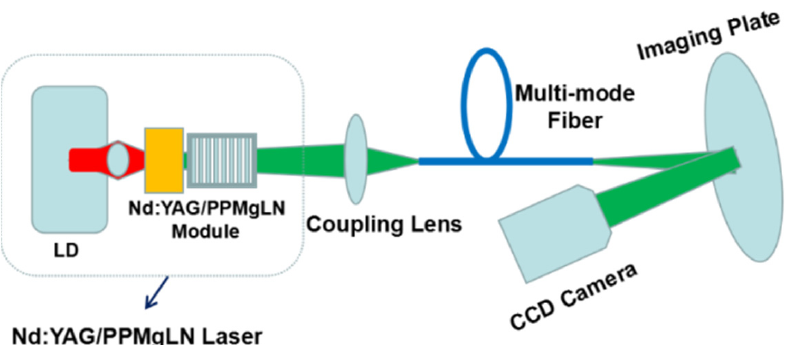
Figure 4. A speckle-suppressed Nd:YAG/PPMgLN laser at 561.5 nm based on a big-core multi-mode fiber.